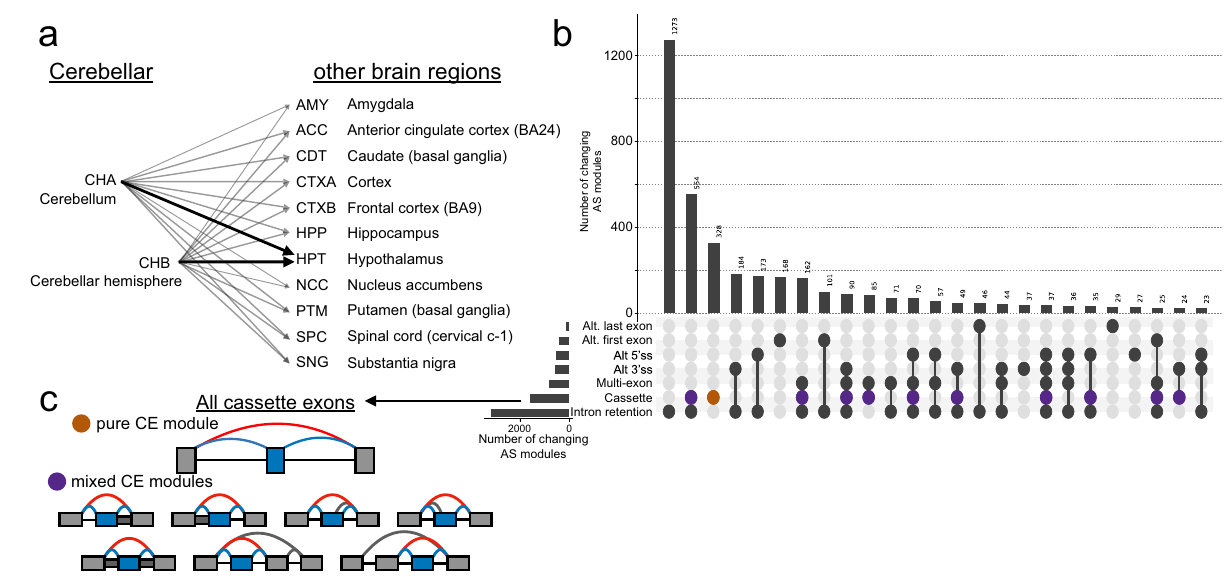
Fig. 5 | MAJIQ HET + VOILA Modulizer de fi nes the complex landscape of cere- bellar splicing changes. a Pairwise comparisons run through MAJIQ HET to fi nd signi fi cant splicing changes between GTEx cerebellar tissues (cerebellum and cerebellar hemisphere) versus the other 11 brain tissue groups. Dark arrows indicate an example of a consistent change, where both cerebellar tissue groups versus the same other brain region, the hypothalamus, shared a signi fi cant change. Alternative splicing (AS)modules were kept fordownstreamanalysisifat least one such consistent comparison was signi fi cant (see “ Methods ” ). GTEx abbreviations are given for each tissue. b Upset plot showing the consistent,